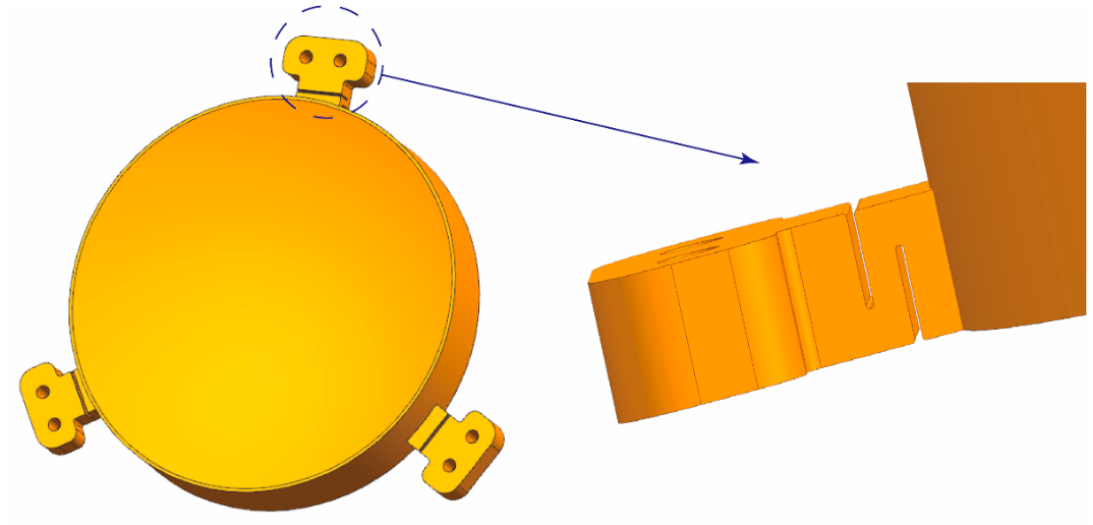
Figure 12. The flexible supporting structure.